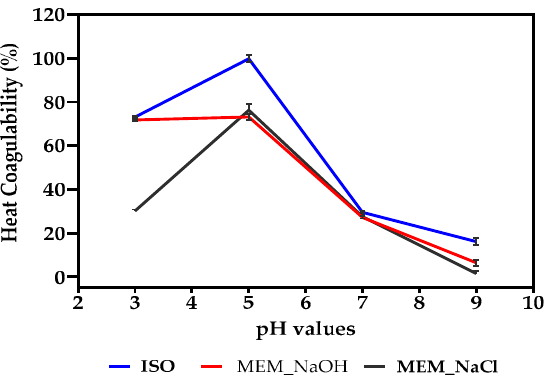
Figure 6. Percentage heat coagulability at pH 3.0–9.0 of isoelectric pH precipitated isolate (ISO), and membrane isolates using alkaline (MEM_NaOH) and salt (MEM_NaCl) solution extracts.